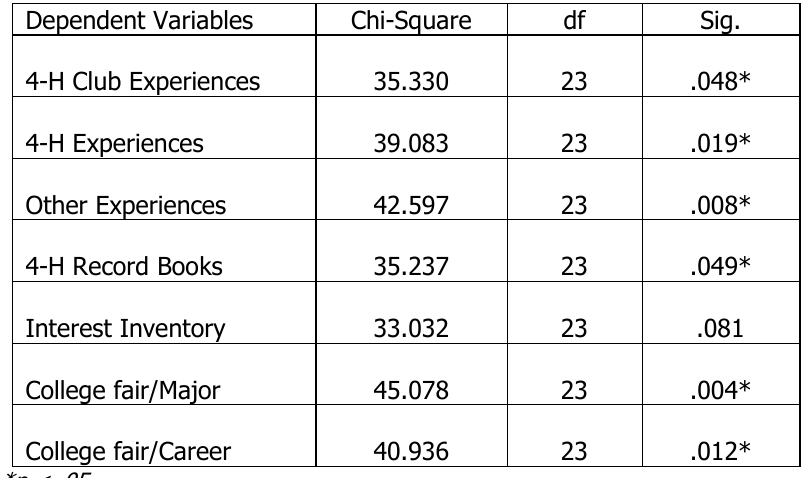
Model Fit for Dependent Variables and Goodness of Fit Dependent Variables Chi-Square df Sig. 4-H Club Experiences